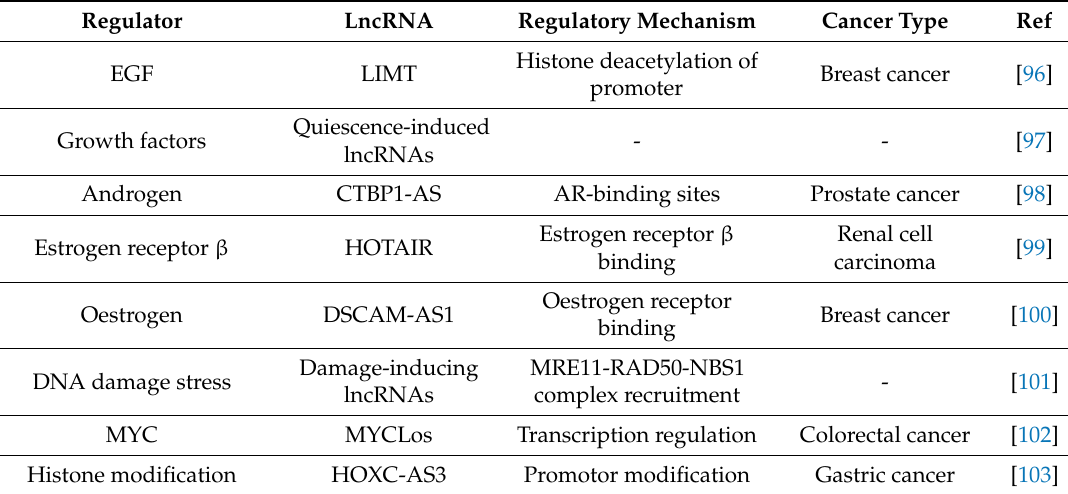
Table 4. Identification of lncRNA